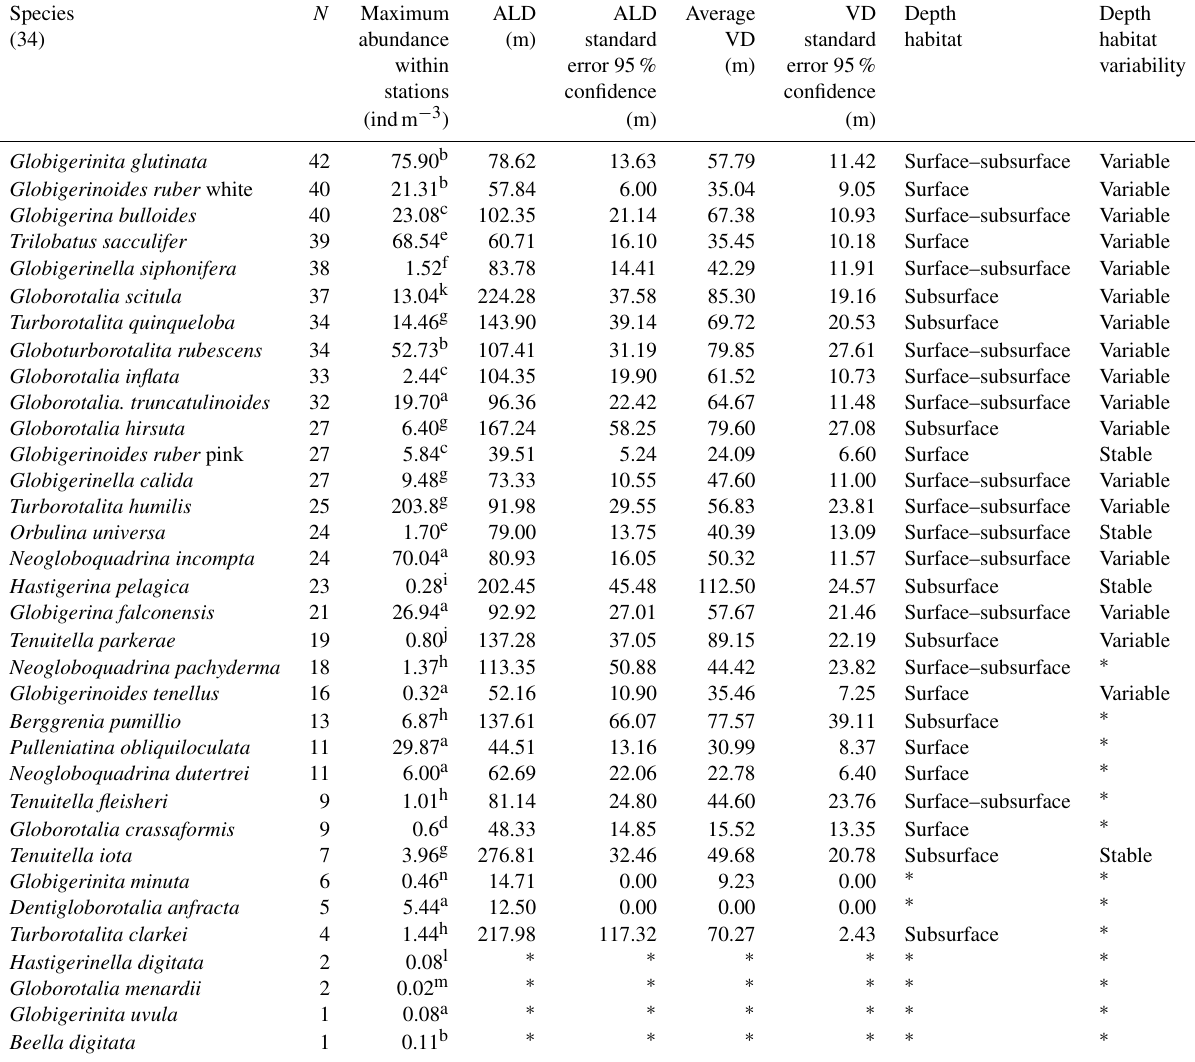
Table 4. The 34 species found within the 43 counted stations are listed below sorted by the number of occurrences within the samples, including concentrations lower than 5indm − 3 per station, stations where the maximum abundance were observed, average ALD and VD, interpretation of each species depth habitat and its corresponding variability or